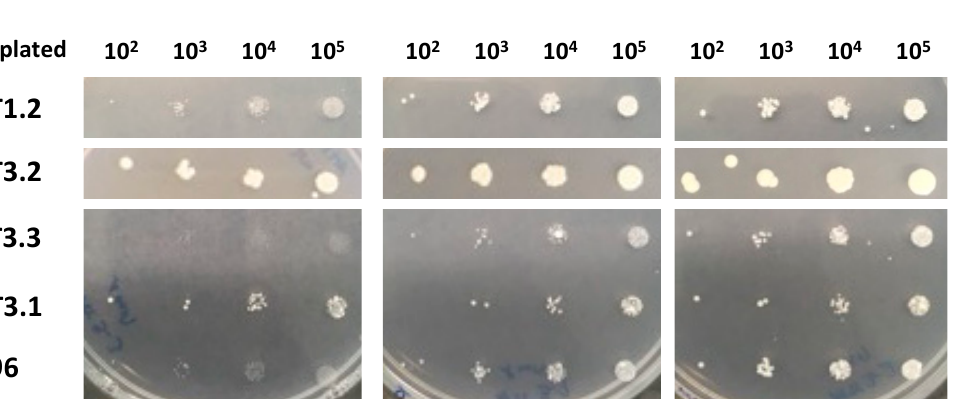
Figure 3. Complementation of a yeast mutant defective in ammonium uptake by QsAMT1.2, QsAMT3.2, and QsAMT3.3. This drop test shows the growth of the yeast strain 31019b, transformed with various constructs, on minimal medium supplemented with various NH4+ concentrations (1, 2 or 3 mM) as a sole nitrogen source. Quantity of yeast cells plated in each drop of 10 µL was between 10 2 –10 5 . All strains were incubated for 5 d at 29 ◦ C. SbAMT3.1 from Sorghum